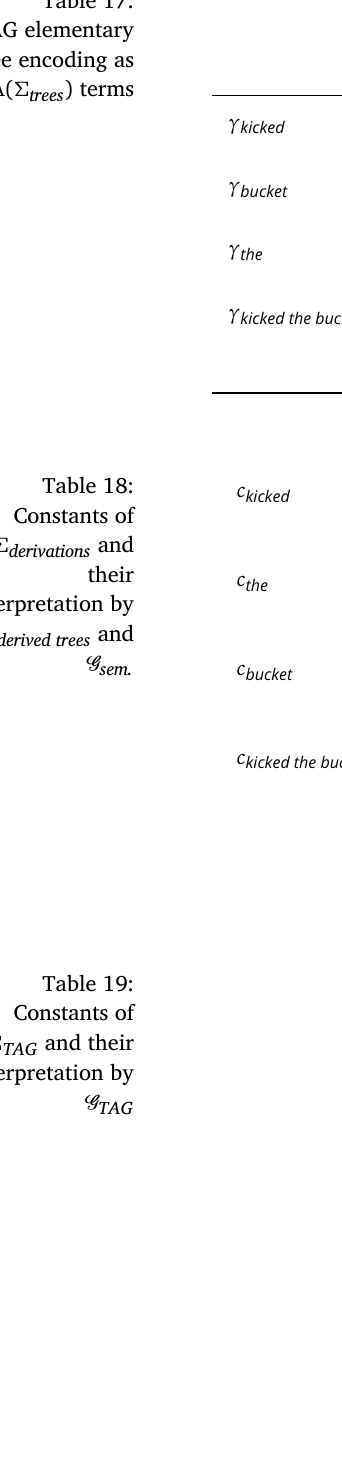
TAG elementary tree encoding as (cid:3)((cid:6) ) terms trees